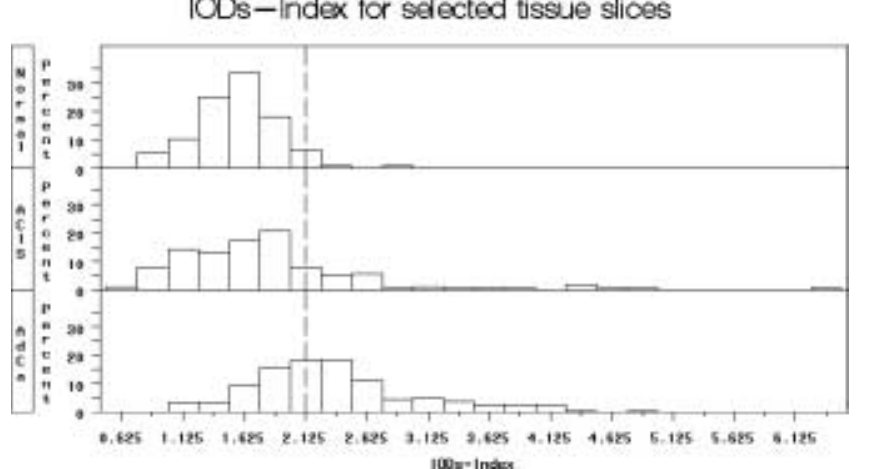
Fig. 4. This plot shows the representative histograms of the IODs-Index value for cells from a Normal, ACIS, and AdCa tissue slice. The dotted line marks the optimal IC value of